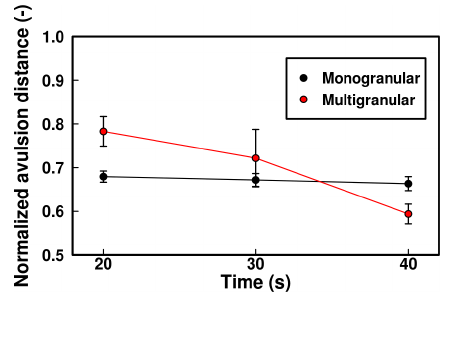
Figure 14. Change in normalized avulsion distance with time. The error bar indicates the standard deviation between the four experi- mental